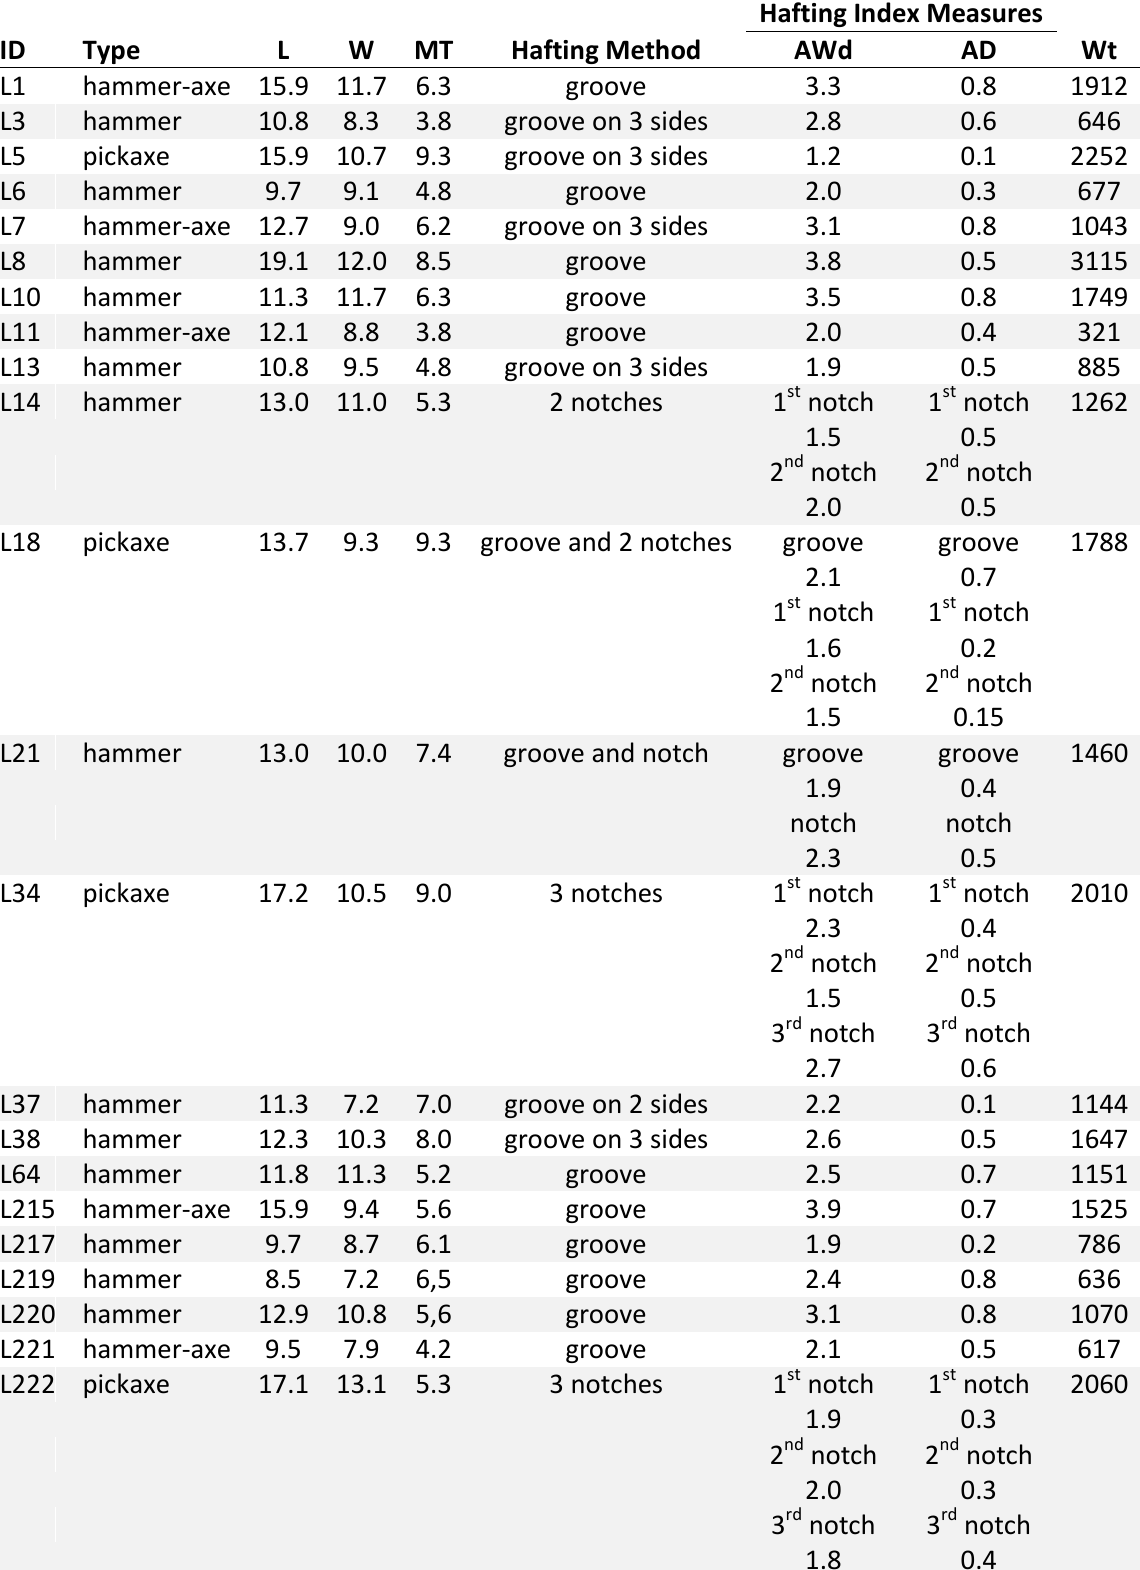
Table 3. ID and quantitative data of the twenty-two intact, or almost intact, grooved stone tools unearthed within Grotta della Monaca. Abbreviations: L - length (cm); Wd - width; MT - maximum thickness (cm); AWd - average width (cm); AD - average depth (cm); Wt - weight